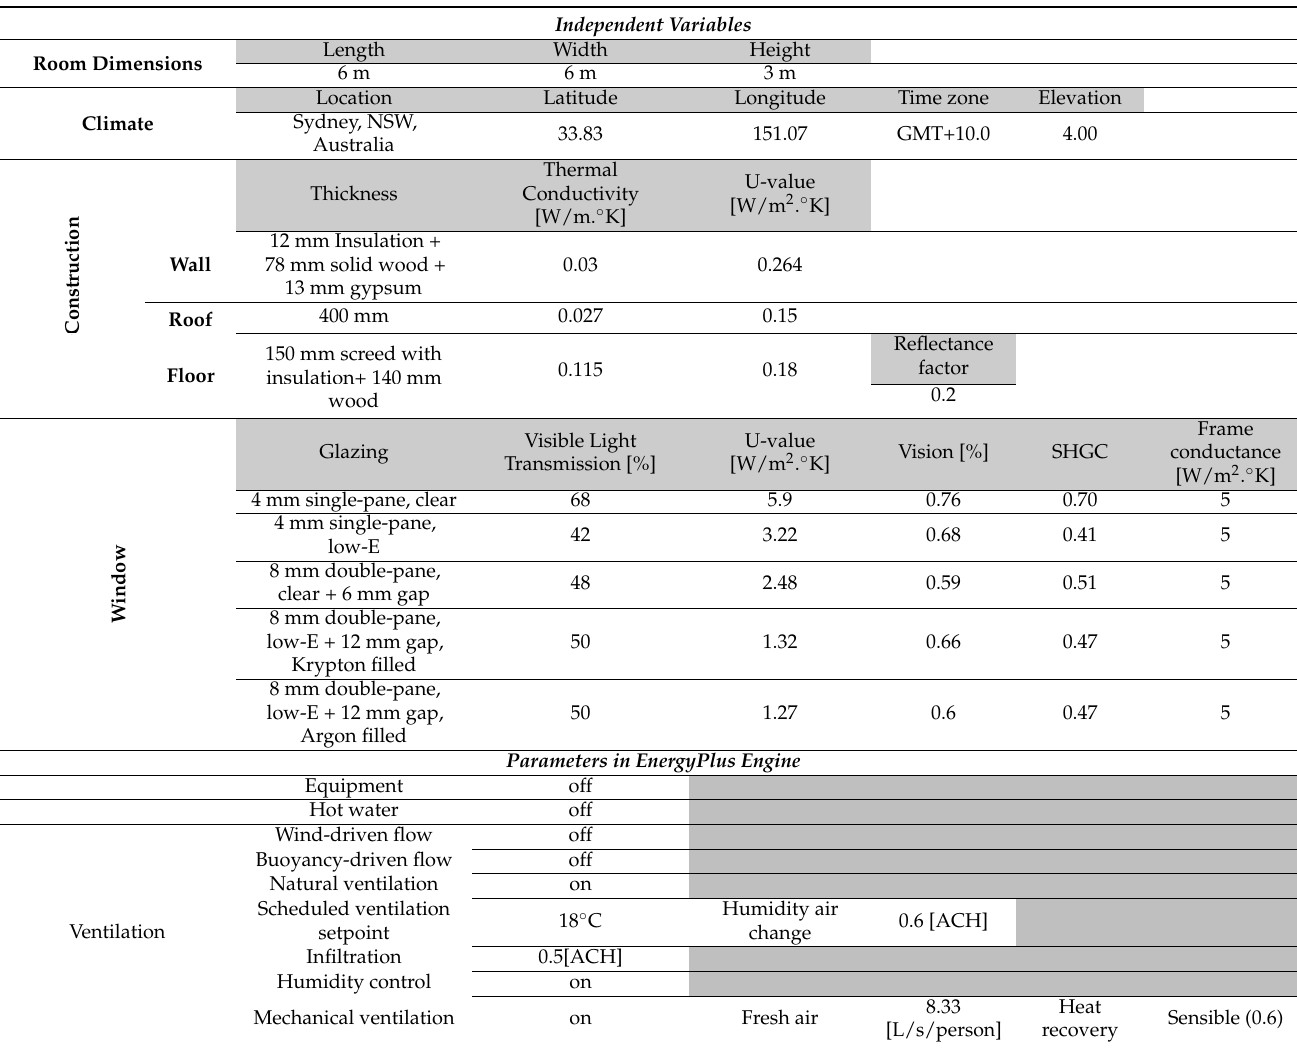
Figure 1. A single zone residential room for the case, genomes in multi-objective simulation through NSGA-II, and acronyms for window and envelope parameters (modeled by authors). Table 1. Independent variables affect the thermal and lighting performance and parameters in simulation. About 80% of the cladding type in NSW is masonry veneer. According to AS/NZS 1680.1:2006, the average recommended illumination for a normal range of tasks from simple to ordinary is 200[lx]. (According to Australian Institute of Refrigeration Air Conditioning and Heating (AIRAH interior and workplace lighting, Part 1: General principles and recommendations) .